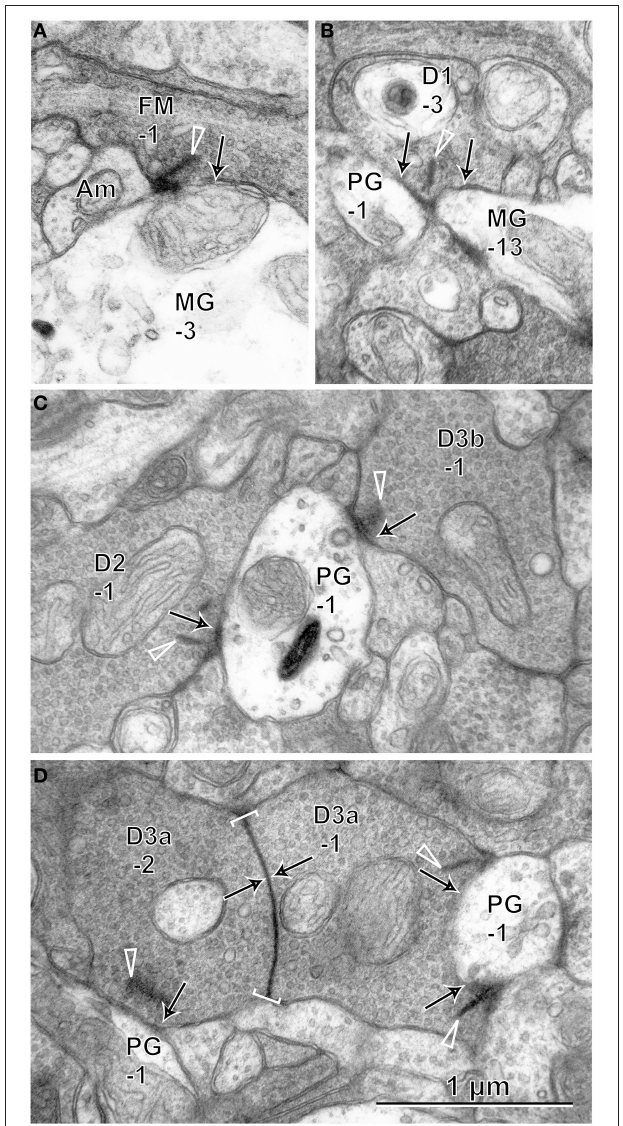
FIGURE 9 | Electron micrographs of synaptic contacts (arrows) of OFF bipolar cells with midget and parasol ganglion cells. (A) The axon of cell FMB-1forms a ribbon (arrow head) synapse with the dendrite of cell MG-3. (B) Cell DB1-3 projects ribbon synapses to the dendrites of two cells MG-13 and PG-1. (C) Cells DB2-1 and DB3b-1 project ribbon synapses to the same dendrite of cell PG-1. (D) Cells DB3a-1 and DB3a-2 are coupled by a gap junction (arrows within brackets) and project ribbon synapses to the dendrites of cell PG-1. Bipolar letterings are abbreviated without